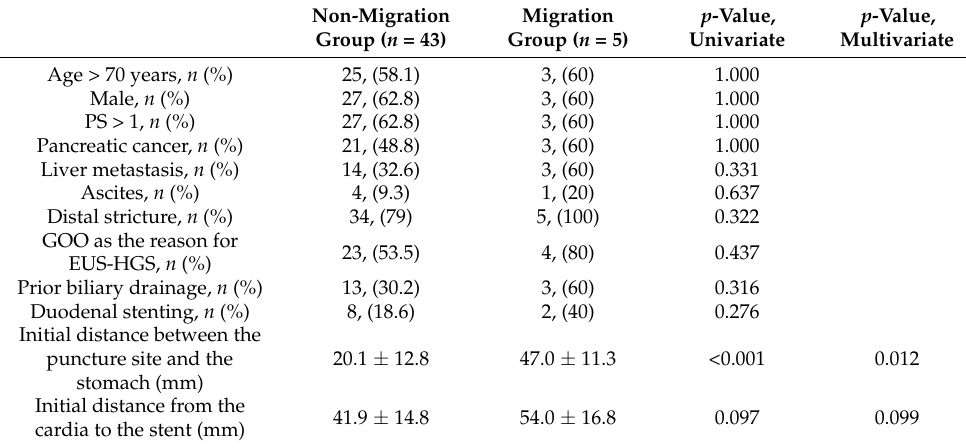
Table 4. Risk factors for stent migration after EUS-HGS.